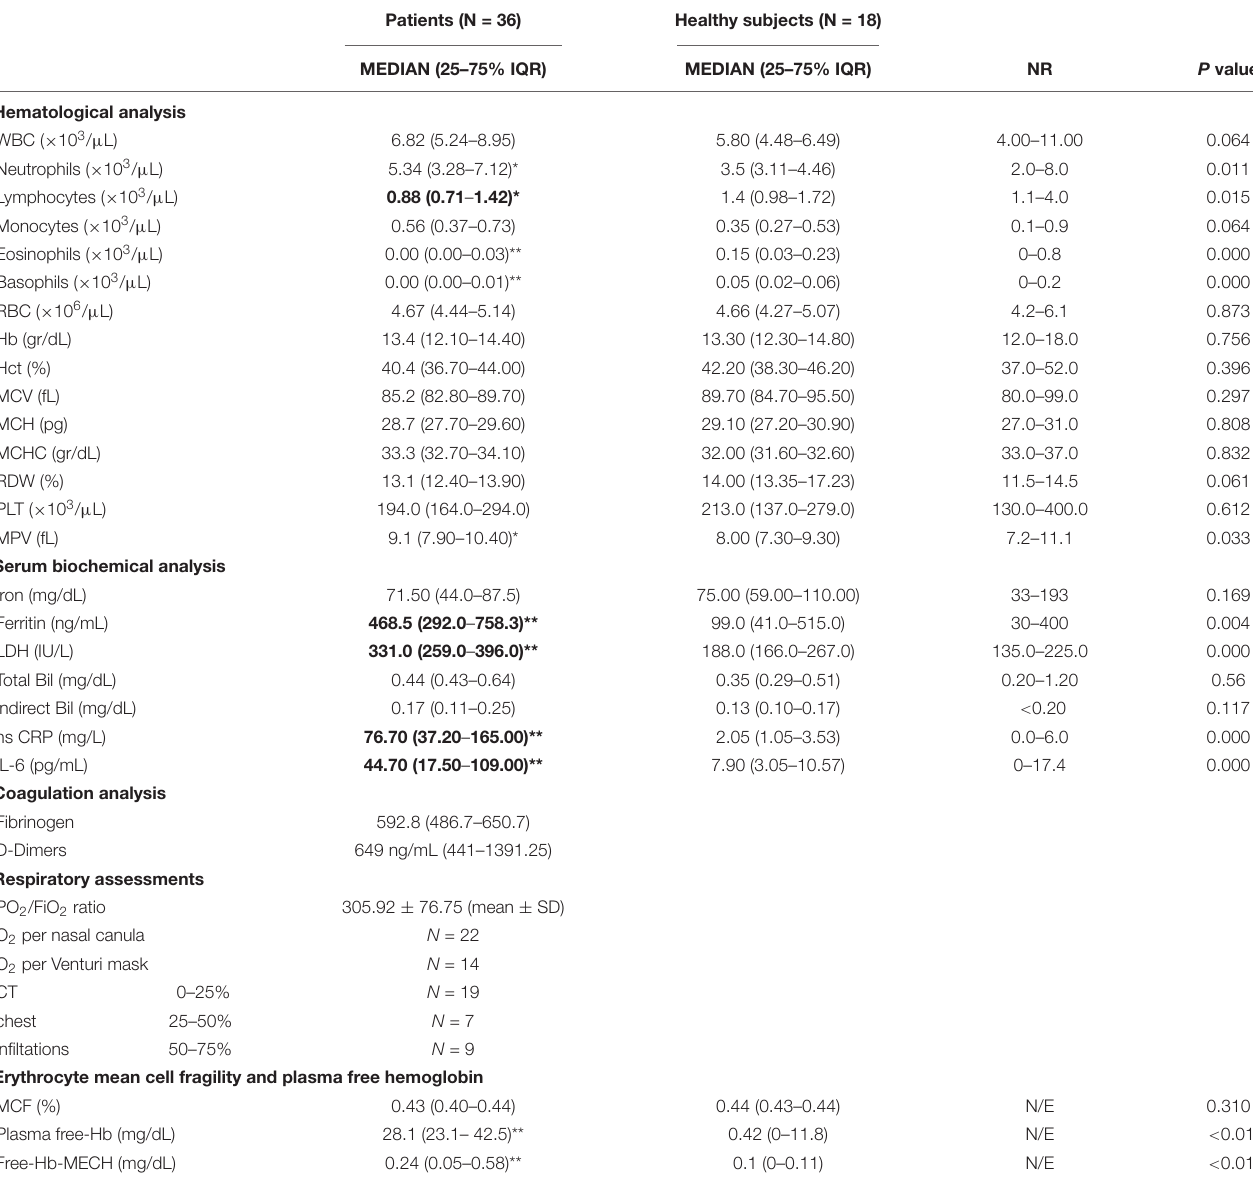
TABLE 1 | Hematological and serum biochemical characteristics and red blood cell hemolysis markers of patients with SARS-CoV-2 upon admission to the hospital and healthy subjects. Patients (N =